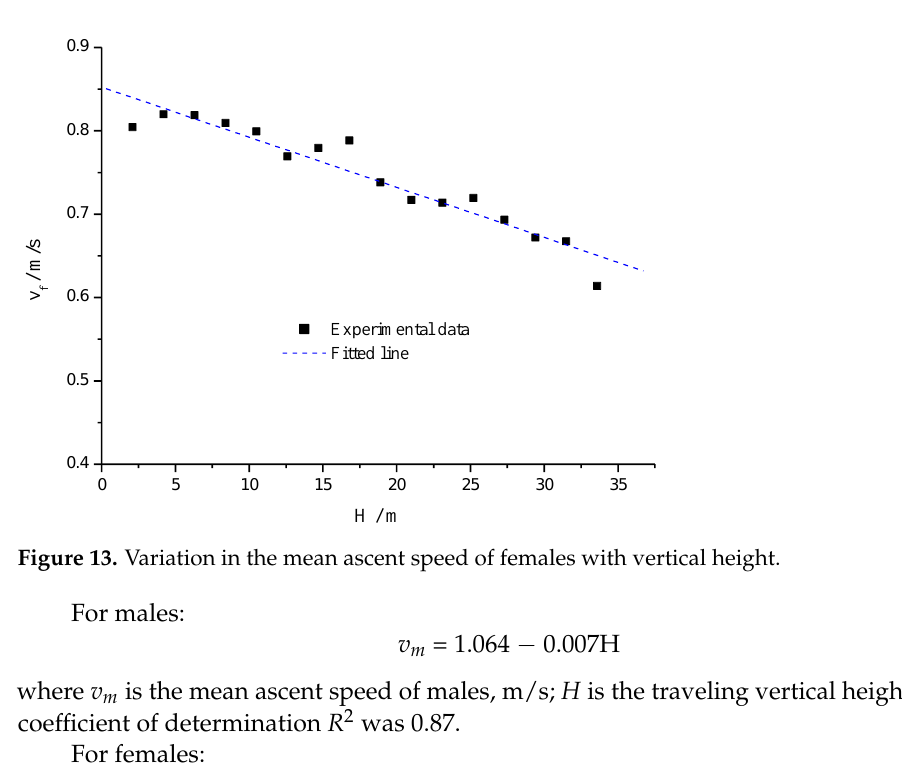
Figure 12. Variation in the mean ascent speed of males with vertical height.